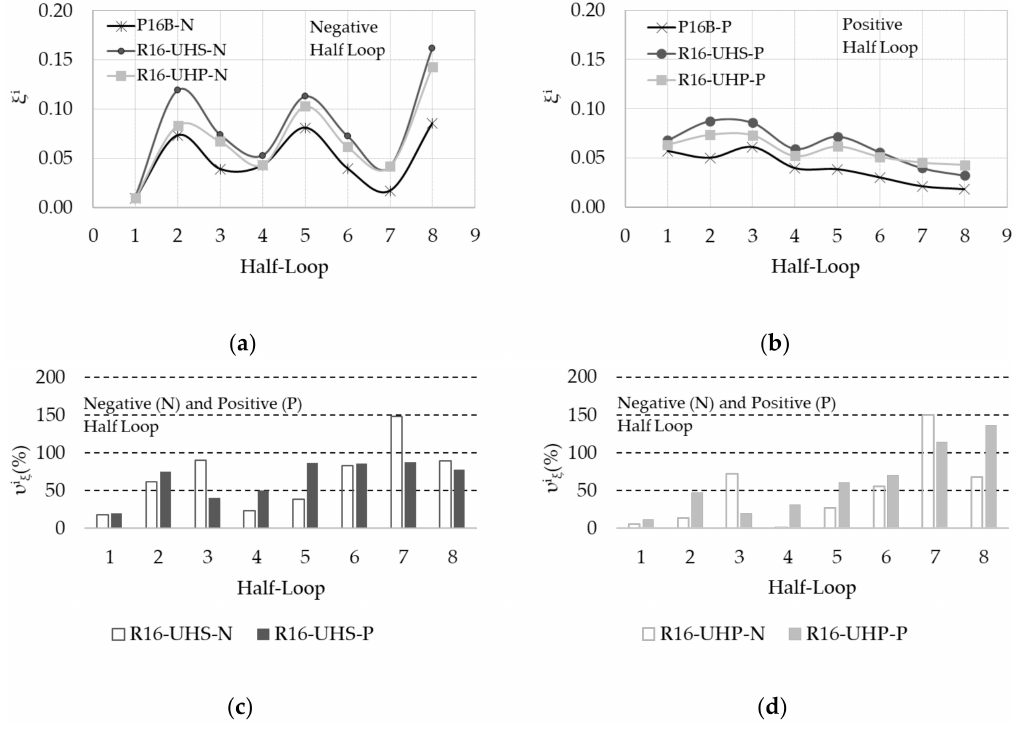
Figure 15. Hysteretic damping ( ξ i ) for each half loop during Tol deformation history of the ASB column (P16B) and the RR columns (R16-UHS, R16-UHP) for the negative ( a ) and the positive ( b ) half loops. Damping increase ( υ i ξ ) for: ( c ) the column R16-UHS and ( d ) the column R16-UHP. The parameter υ i defined by Equation (17) estimates the variation in the damping after ξ column